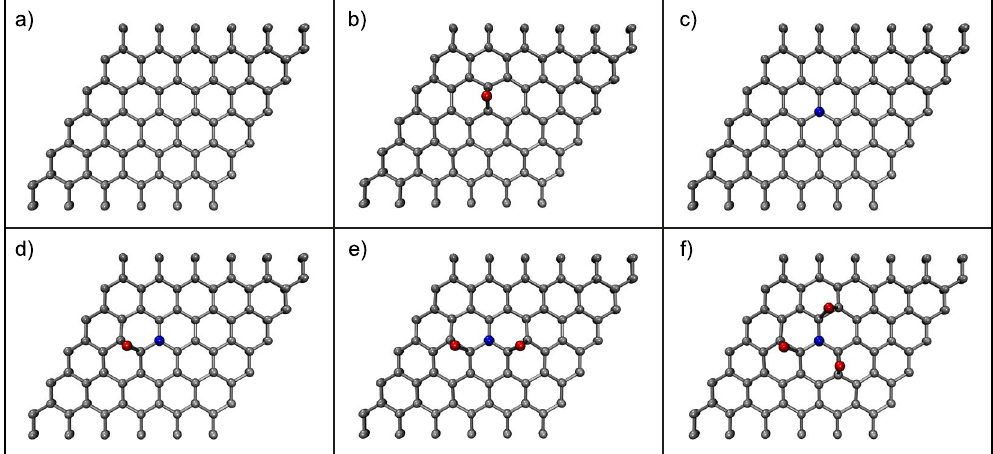
Figure 3. Supercells of DFT-relaxed graphene structures (carbon atoms are coloured grey, oxygen red, and nitrogen blue). ( a ) Pristine and ( b ) epoxide-functionalized graphene; ( c ) graphitic N; ( d – f ) graphitic N with ( d ) one, ( e ) two, or ( f ) three epoxide O adsorbed at their preferred binding sites over the N-neighbouring C-C bonds.